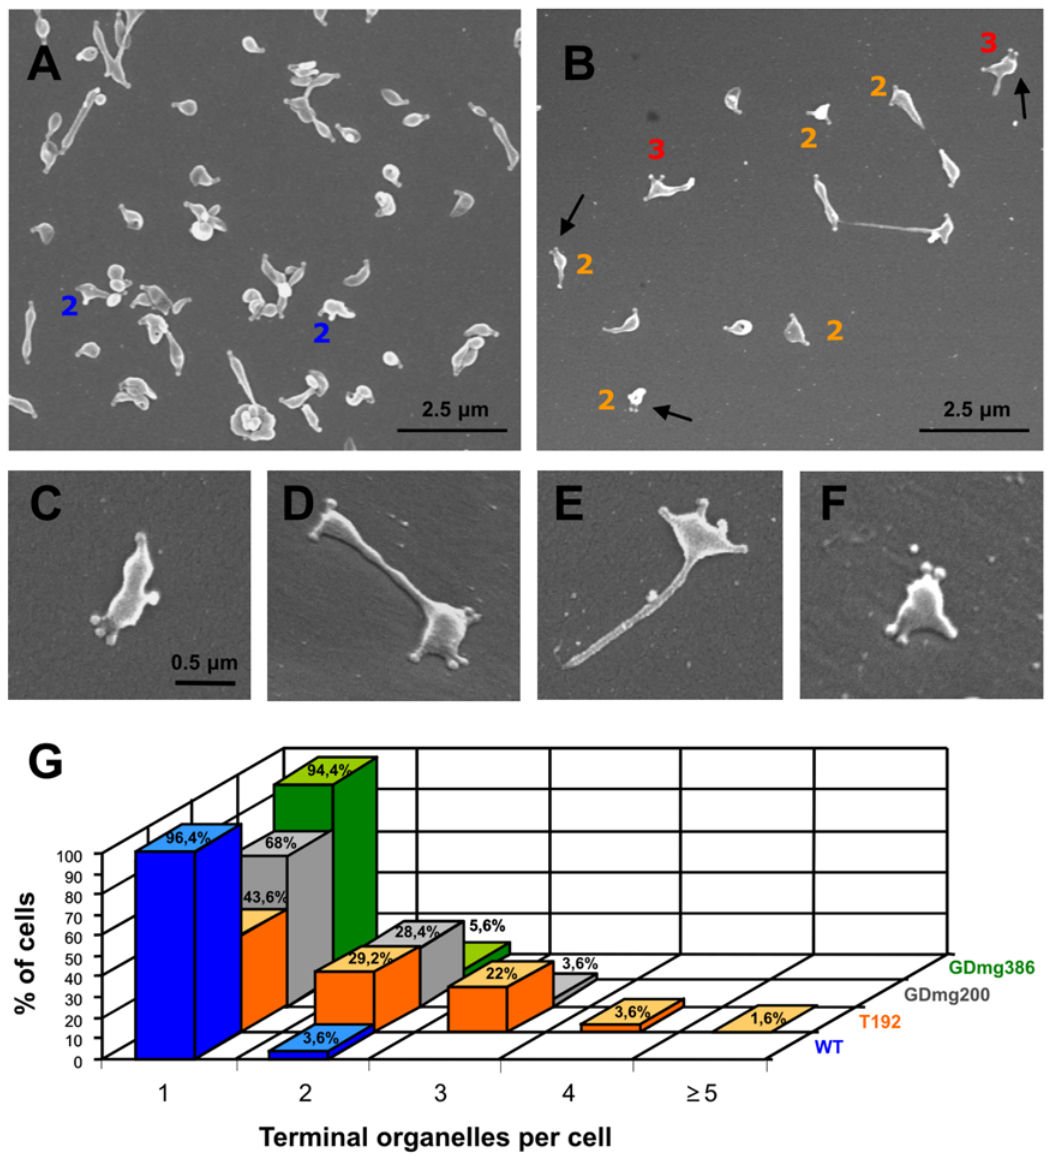
Figure 6. Scanning electron microscopy analysis. Electron micrographs of the WT strain (A) and the T192 mutant (B–F). In (G), graphic showing the percentage of cells with one, two, three, four and five or more TO in the WT strain, the T192 mutant, and the motility mutants GDmg200 c12 and GDmg386 c1. Arrows point out cells with two TO together at the same cell pole. The number of TO per cell are indicated in cells with more than one TO. Images in panels C to F are shown at the same